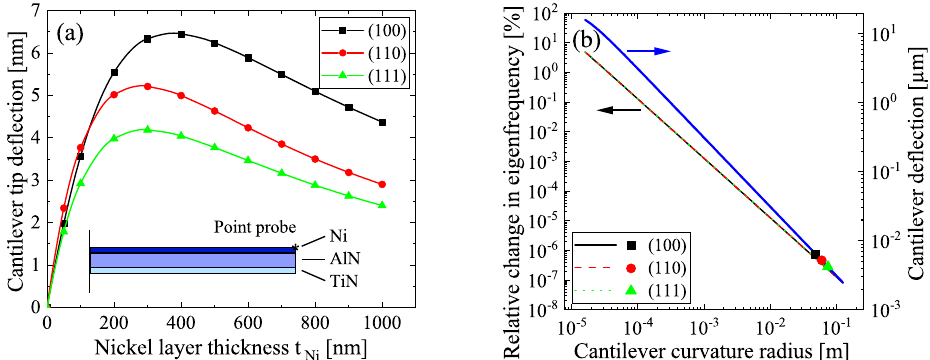
Figure 3. ( a ) Deflection in magnetic saturation of the simulated cantilever for different thicknesses t Ni . ( b ) Influence of the cantilever curvature on the eigenfrequency. The curvature caused by magnetostriction is derived for comparison from ( a